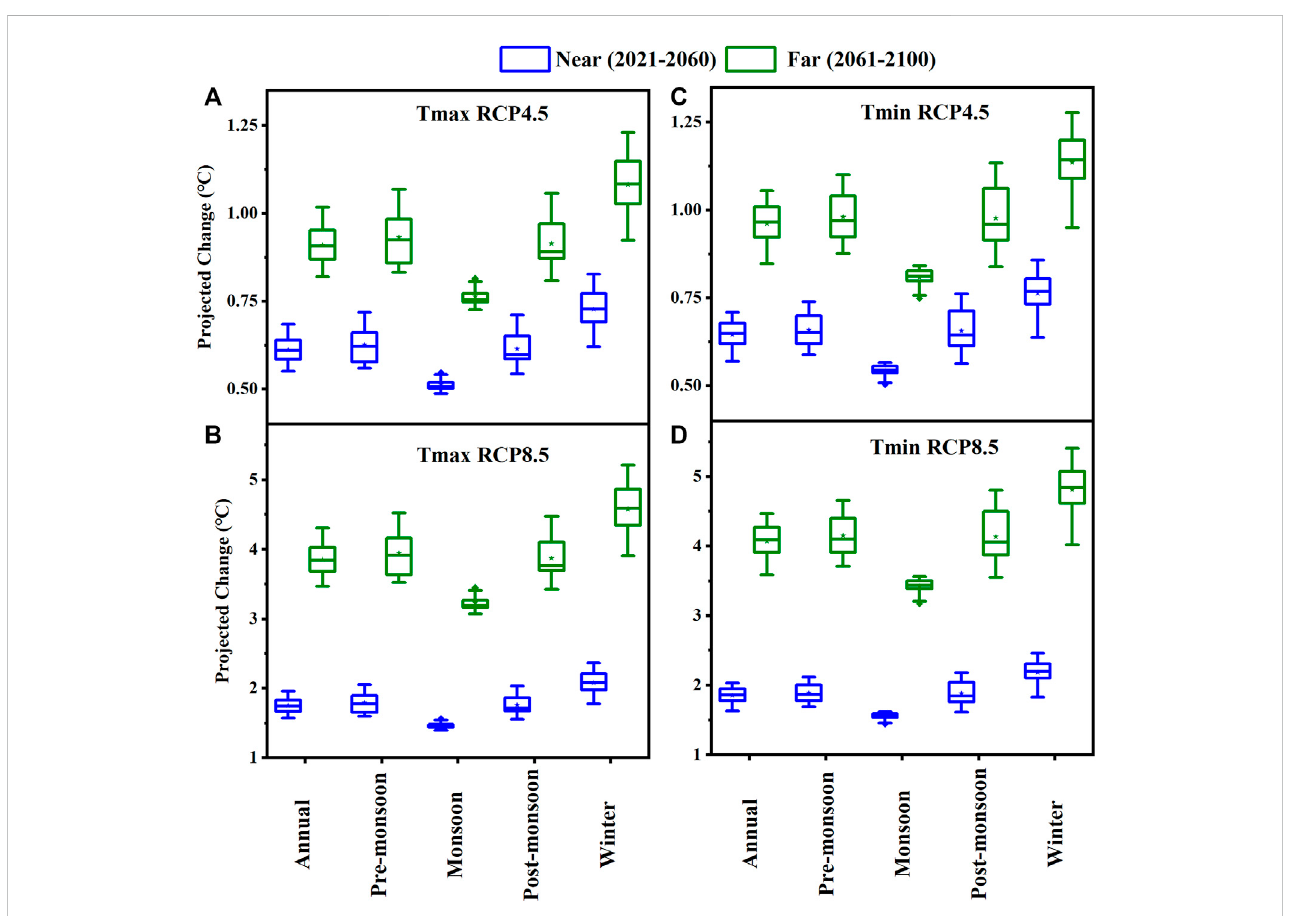
FIGURE 11 Projected change in annual and seasonal temperature for near (2021 – 2060) and far (2061 – 2100) future periods in Bangladesh for RCP4.5 and RCP8.5. (A) Tmax RCP4.5, (B) Tmax RCP8.5, (C) Tmin RCP4.5, and (D) Tmin